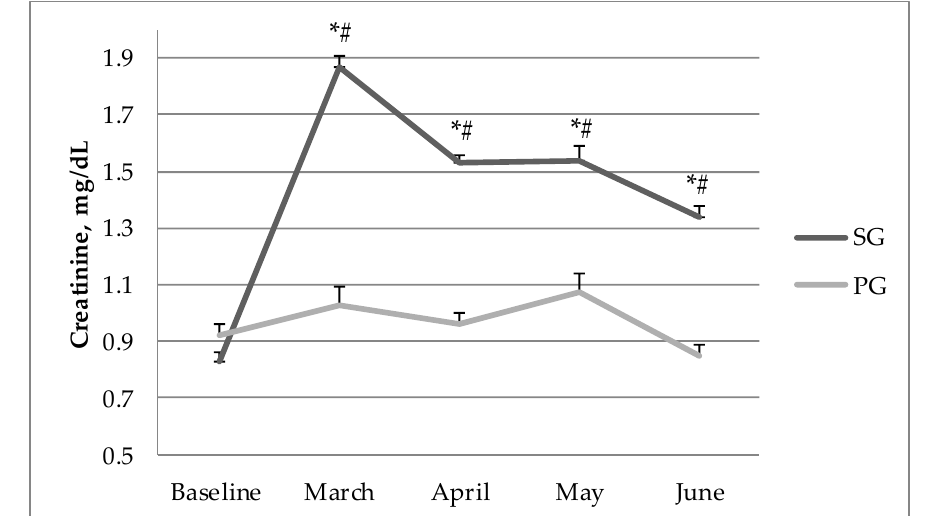
Figure 2. Serum creatinine concentration at baseline and during four months of supplementation in the SG and PG. SG—supplemented group, PG—placebo group. * significant difference compared with baseline in the SG, # significant difference compared with the PG. Table 3. The Running Anaerobic Sprint Test (RAST) results before and after the supplementation intervention.